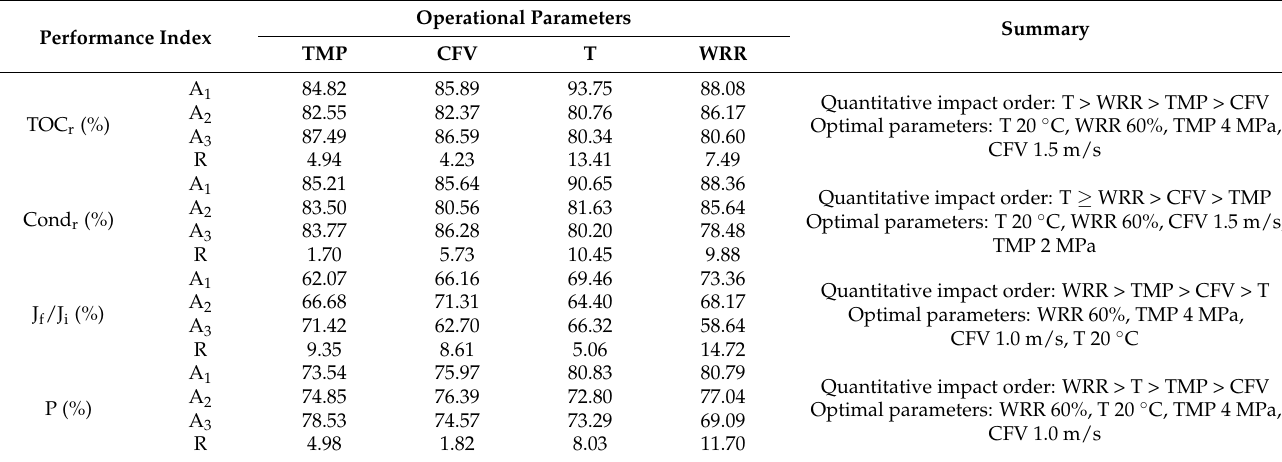
Table 7. Range analysis of the orthogonal tests for DuPont Filmtec BW RO membrane.